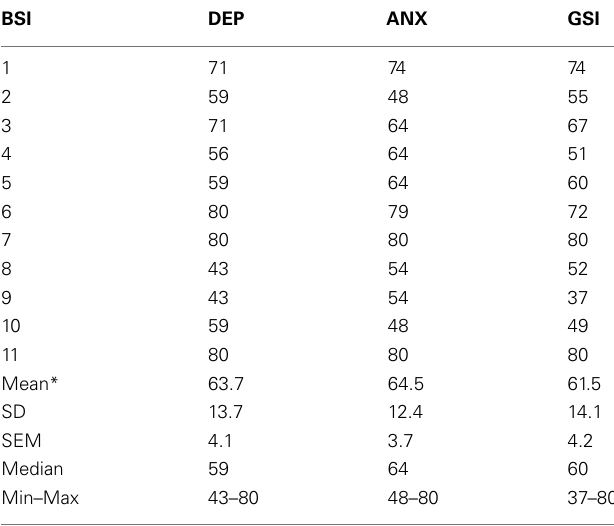
Table 2 | Comorbidities assessed with the Brief Symptom